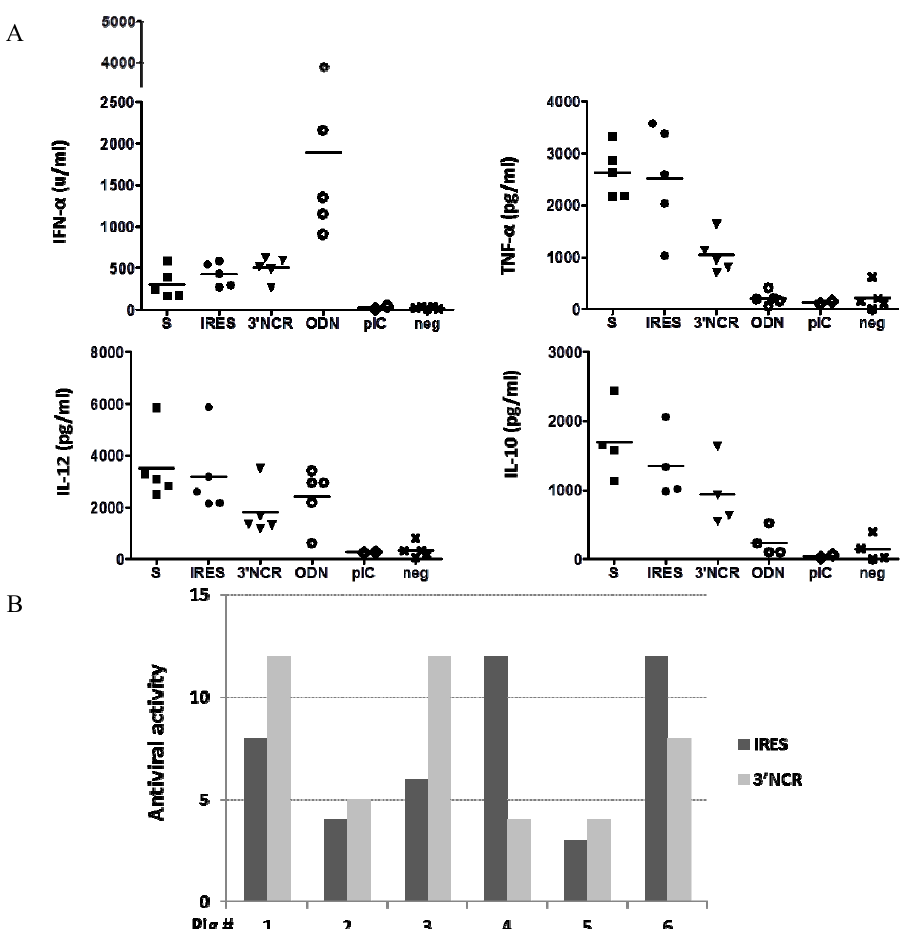
Figure 4. Innate responses in transfected PBMCs from different pigs and two independent experiments. ( A ) PBMCs were isolated from five 9 to 12-month-old pigs and transfected with 20 μ g/mL S, IRES, 3 ′ NCR, mock-transfected (negative control), or stimulated with ODN (10 μ g/mL) or poly I:C (10 μ g/mL) ( n = 2). The levels of IFN- α , TNF- α , IL-12